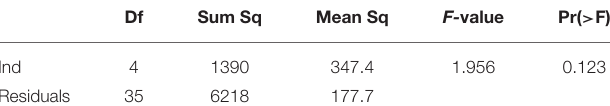
TABLE 3 | ANOVA on spore counts in infected groups with Nosema ceranae .